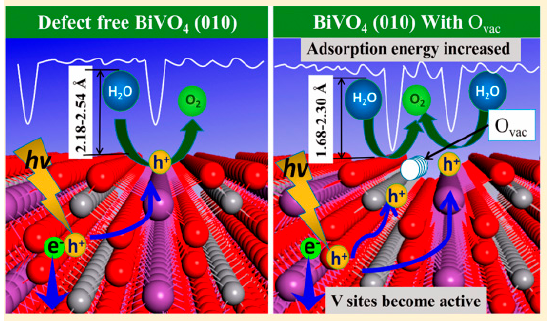
Figure 22. PEC water splitting process on a BiVO 4 (010) facet with or without O vac . O vac will greatly affect the adsorption energy. Reprinted with permission from ref. [85]. Copyright 2017. American Chemical Society.